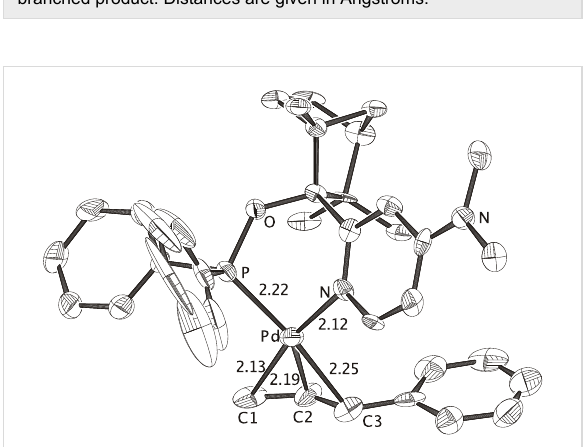
Figure 2: X-ray crystal structure of the cationic complex Pd-FENOP- Me (CCDC 600369), the perchlorate counterion and hydrogen atoms are omitted. The allylic phenyl groups is positioned trans to phos- phorus. In agreement with the " trans rule", C3-Pd is longer then C1-Pd. The nucleophile (i.e. malonate) is expected to attack at C3 yielding the branched product. Distances are given in Angstroms.